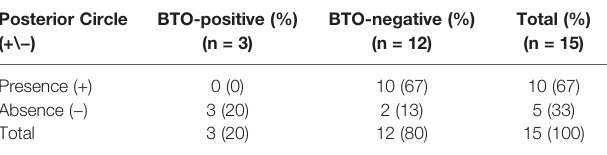
TABLE 4 | The summary of the relationship between the absence of Posterior Circle and its BTO results in Subgroup